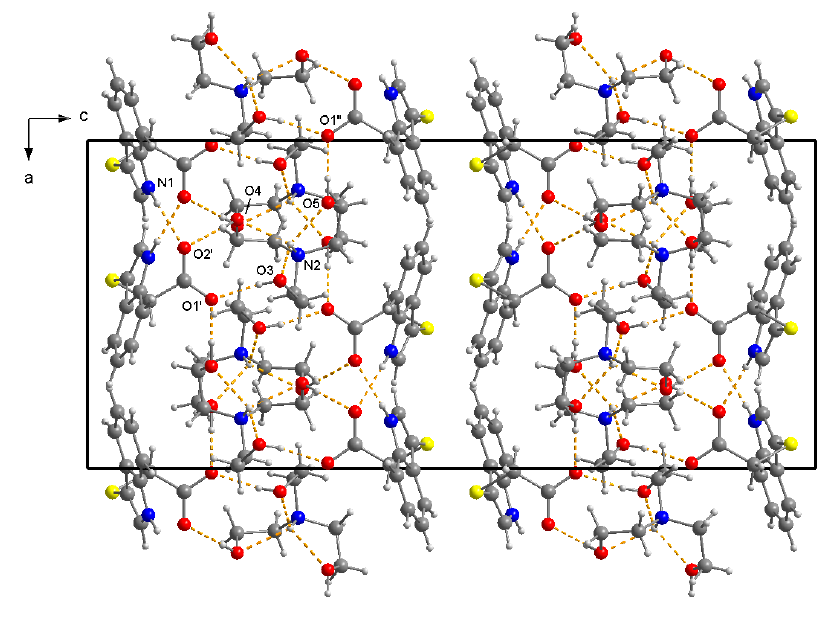
Figure 2: Crystal packing of 1, illustrating hydrogen bonds (dashed lines). Symmetry operators: ‘0.5-x, y-0.5, z; ‘‘-x, y-0.5, 0.5-z. Table 2: Selected bond lengths (Å), bond angles (°), and torsion angles (°). Table 3: Hydrogen bond geometry (Å,